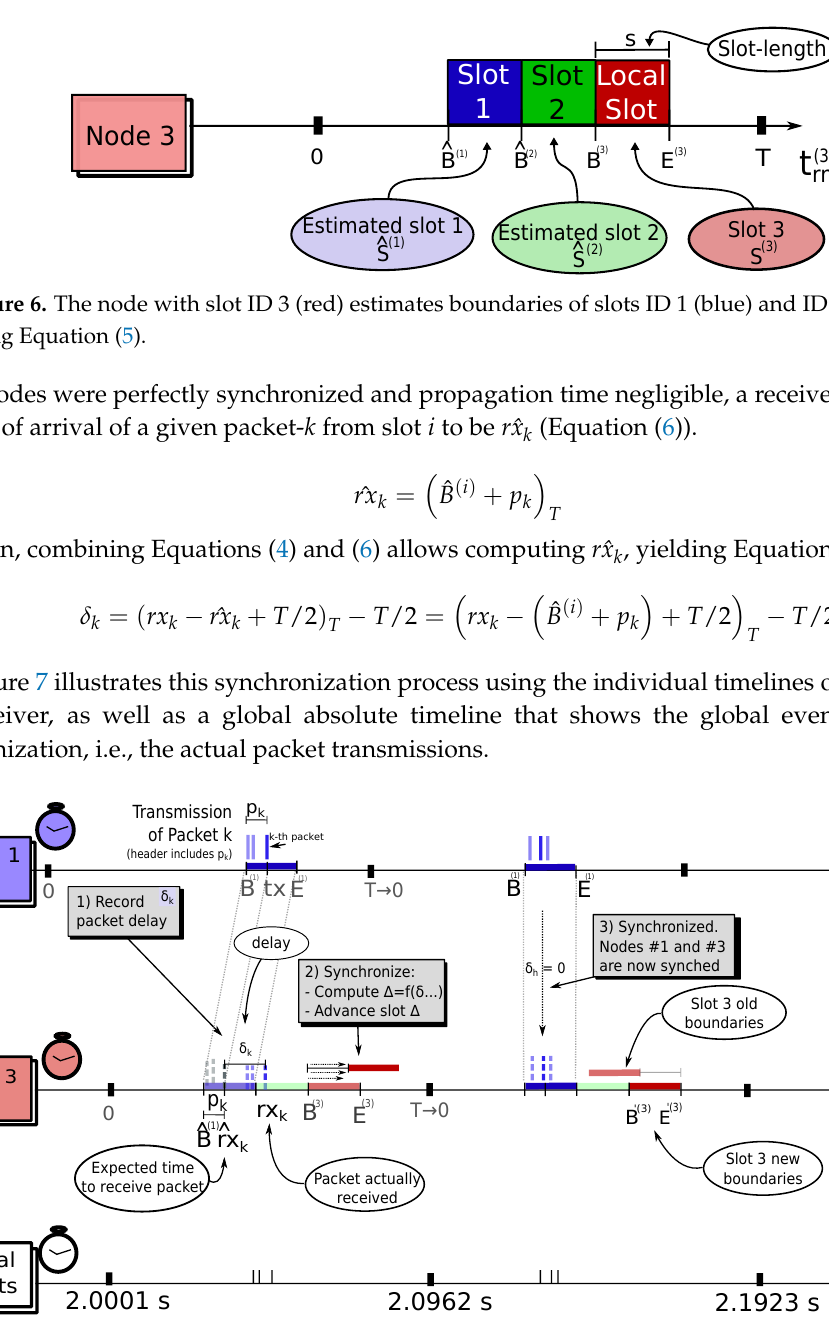
Figure 7. Shifting slots in the TDMA round to enforce synchronization. The upper timeline shows the local time frame of Node 1 as the transmitter, which was slightly advanced (blue slot). The middle timeline shows the local time frame of Node 3 as receiver, which senses Node 1 slot advancement and shifts its own slot (red slot), accordingly, maintaining synchronization. The lower timeline shows the global synchronization events, i.e., packets’ transmissions, on a virtual absolute time frame. Right at the beginning of each transmission slot, the respective owner node analyzes all the packet delay estimates saved during the previous round ( δ 1 , δ 2 , . . . ) to compute an aggregated delay function f ( δ 1 , δ 2 , . . . ) and resets the packet delay estimates for the next round. Node j , then, shifts (advances)